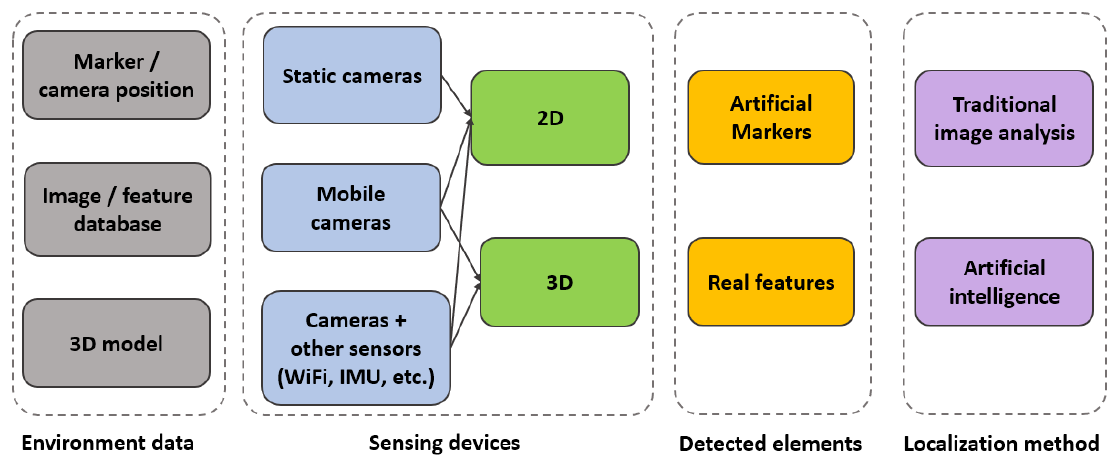
Figure 3. Proposed classification based on environment data, sensing devices, detected elements, and localization